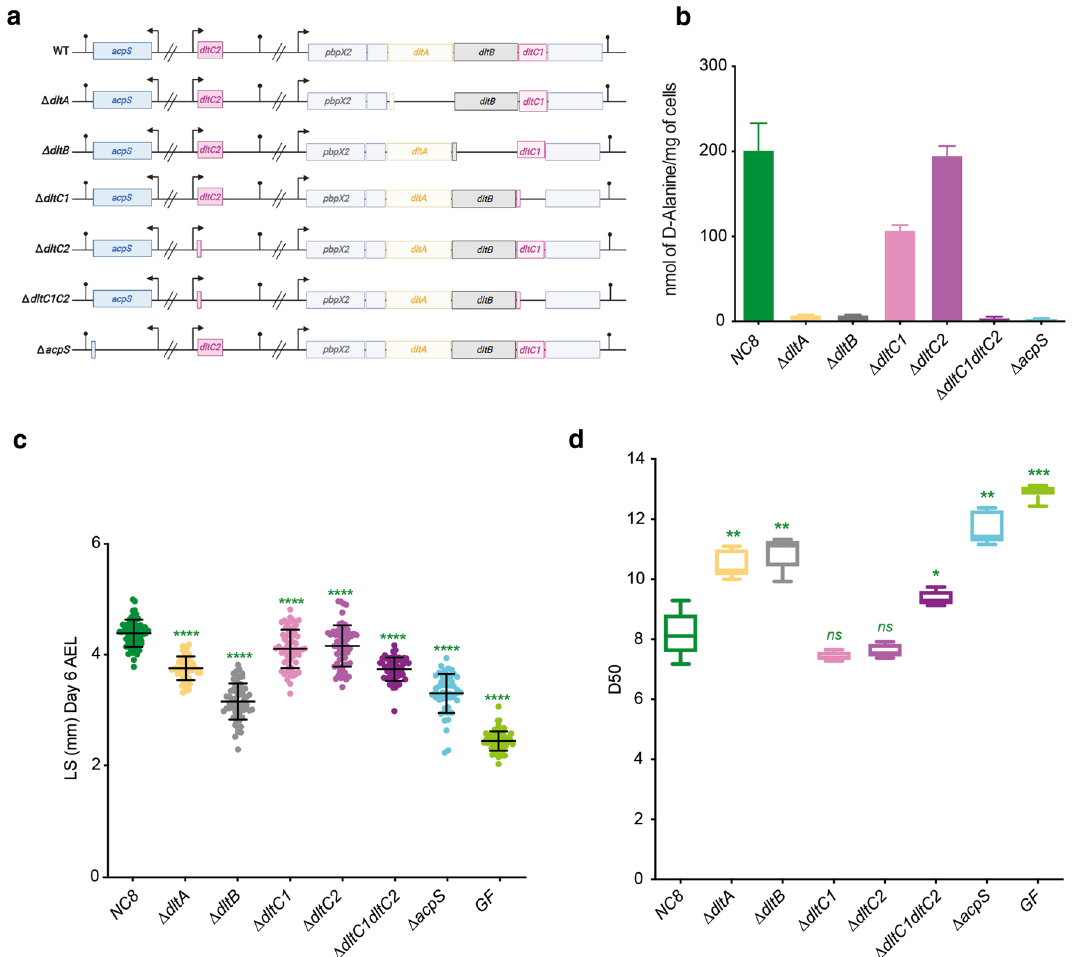
Figure 1. Characterization of L. plantarum mutants in Drosophila ’s growth. ( a ) Genetic organization of Lp engineered strains: WT corresponds to Lp NC8 strain; ∆ dltA corresponds to Lp NC8 deleted for dltA gene; ∆ dltB corresponds to Lp NC8 deleted for dltB gene; ∆ dltC1 corresponds to Lp NC8 deleted for dltC1 gene; ∆ dltC2 corresponds to Lp NC8 deleted for dltC2 gene; ∆ dltC1C2 corresponds to Lp NC8 deleted for dltC1 and dltC2 genes; ∆ acpS corresponds to Lp NC8 deleted for acpS gene. in-frame deletions were constructed through homology- based recombination with double-crossing over, in such a way that the two first triplets of the sequence are fused with the two last. ( b ) Amount of d-Ala released from whole cells of NC8 and derivative mutants by alkaline hydrolysis and quantified by HPLC. Error bars represent the standard deviations. ( c ) Larval longitudinal length after inoculation with strains Lp NC8 , ∆ dltA, ∆ dltB, ∆ dltC1 , ∆ dltC2, ∆ dltC1dltC2 , ∆ acpS or PBS (for the GF condition). Larvae were collected 6 days after association and measured as described in the Methods section. Green asterisks illustrate statistically significant difference with Lp NC8 larval size; ****: p < 0.0001. Center values in the graph represent means and error bars represent SD. Representative graph from one out of three independent experiments. ( d ) Day when fifty percent of pupae emerge during a developmental experiment (D50) for GF eggs associated with strains Lp NC8 , ∆ dltA, ∆ dltB, ∆ dltC1 , ∆ dltC2, ∆ dltC1dltC2 , ∆ acpS or PBS (for the GF condition). Center values in the graph represent means. Green asterisks illustrate statistically significant difference with Lp NC8 D50; ns represent absence of statistically significant difference with Lp NC8 D50. ***: 0.0001 < p < 0.001; **: 0.001 < p < 0.01; *: p <